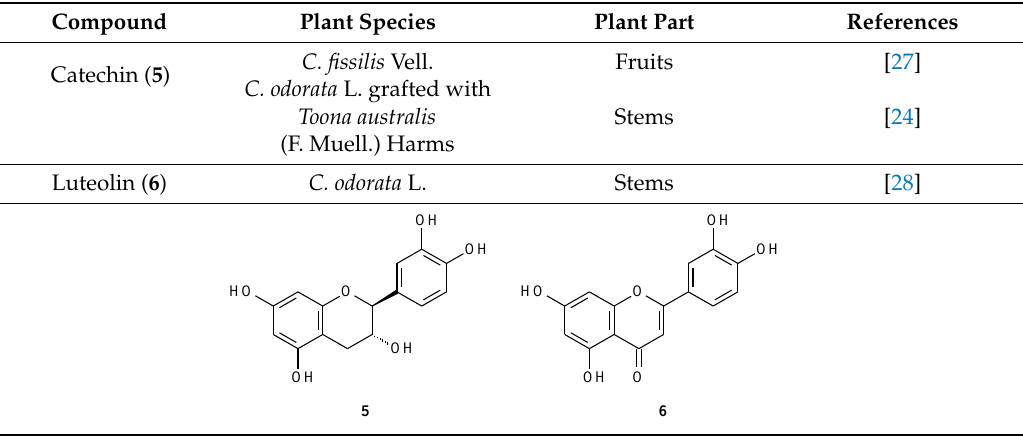
Table 3. Tocopherol isolated from the genus Cedrela (1960–2019) Compound